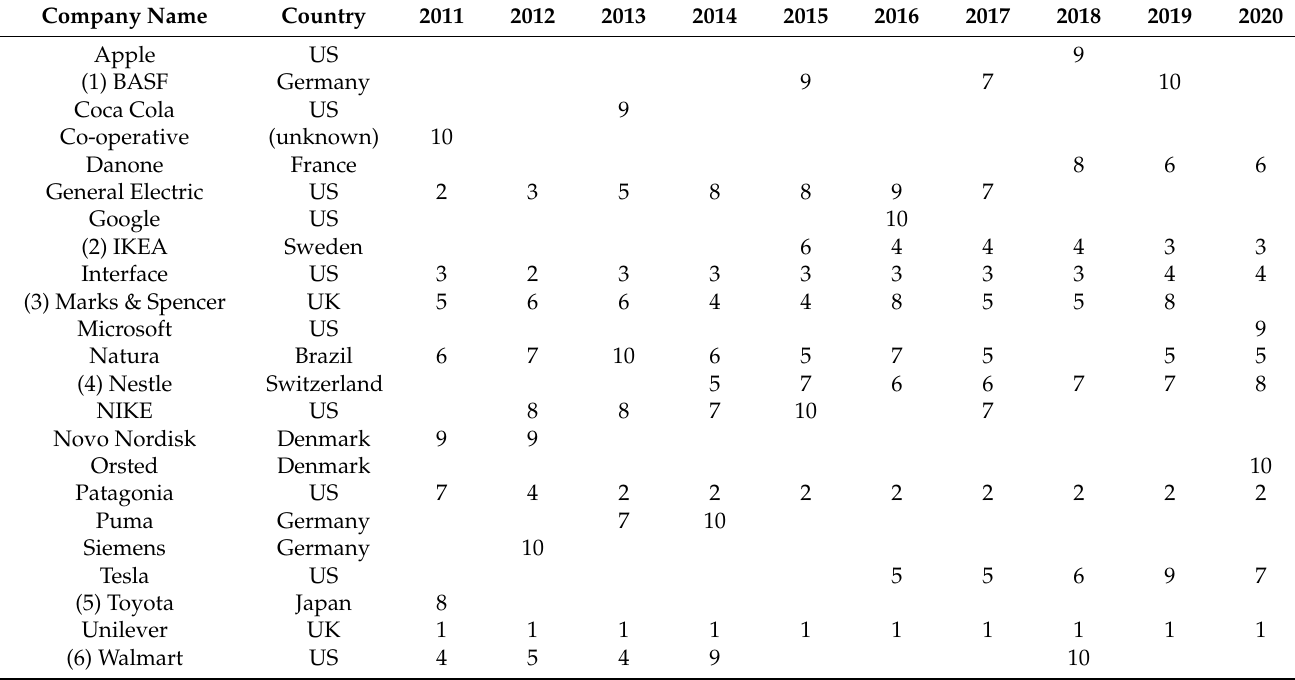
Table 1. Summary of corporate sustainability leader rankings from 2011 to